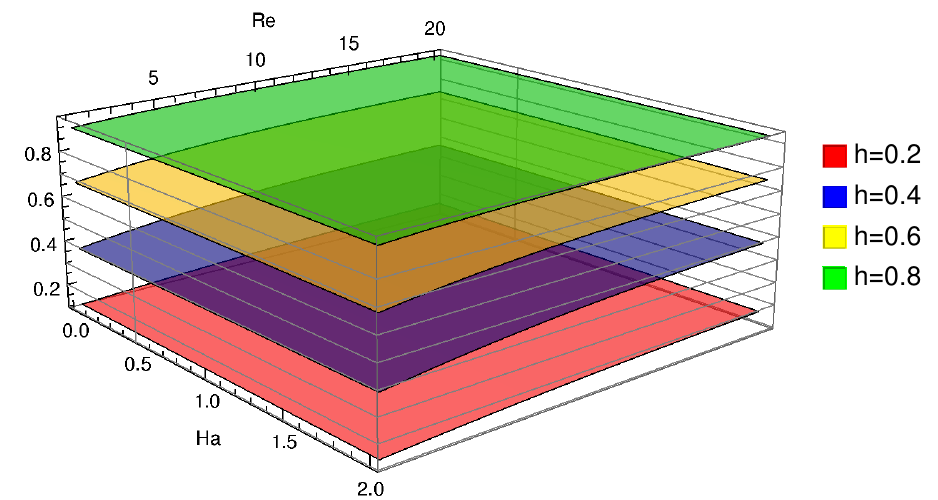
Figure 8. The combined influence of Re and Ha on V . The red surface corresponds to y = 0.2, the blue surface to y = 0.4, the yellow surface to y = 0.6, and the green one to y =